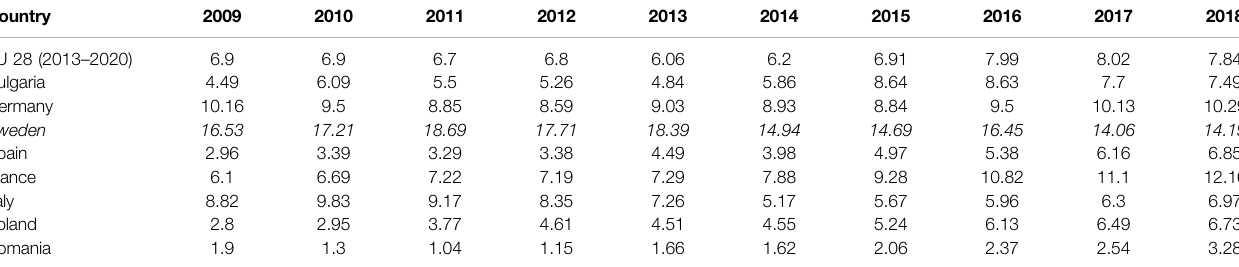
Italics represents the highest values of the analysed indicator.